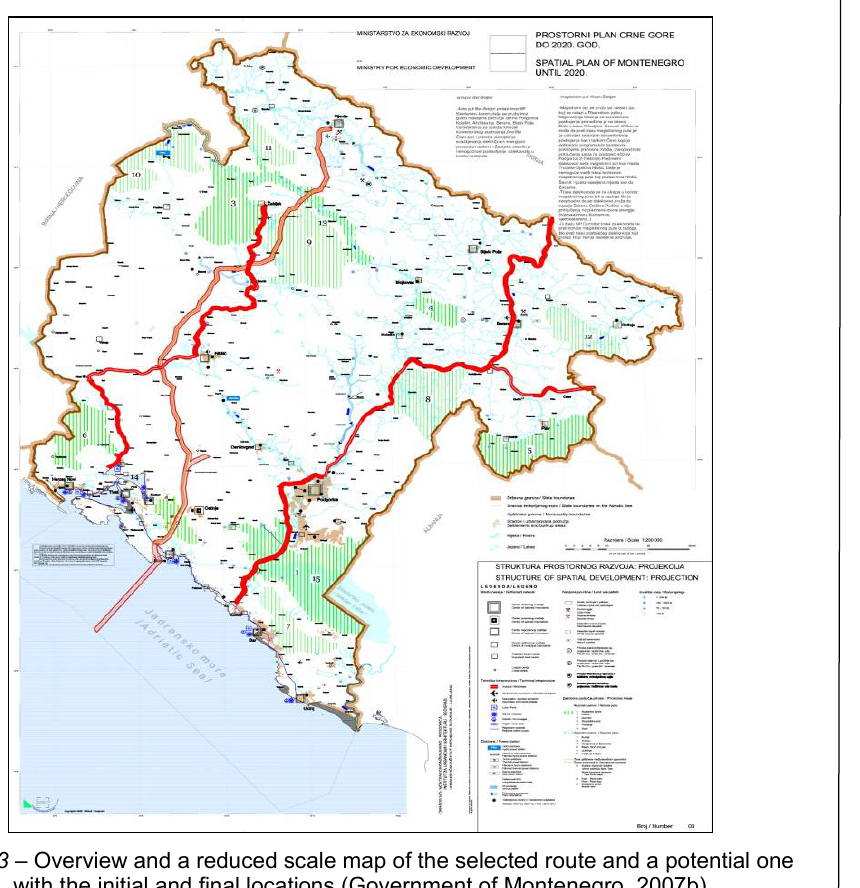
Figure 3 – Overview and a reduced scale map of the selected route and a potential one with the initial and final locations (Government of Montenegro,